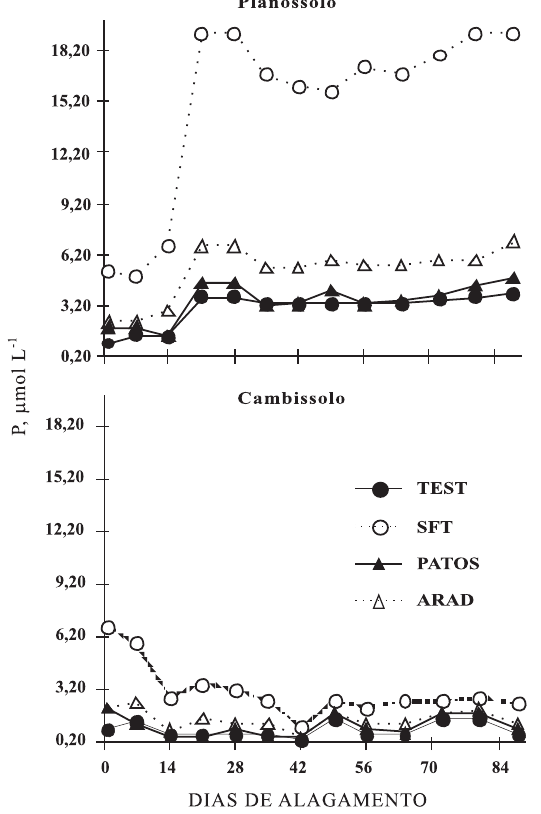
Figura 1. Concentrações de P na solução de dois solos alagados, em função de três fontes de P. TEST: testemunha; SFT: superfosfato triplo; PATOS: fosfato natural de Patos de Minas; ARAD: fosfato natural de